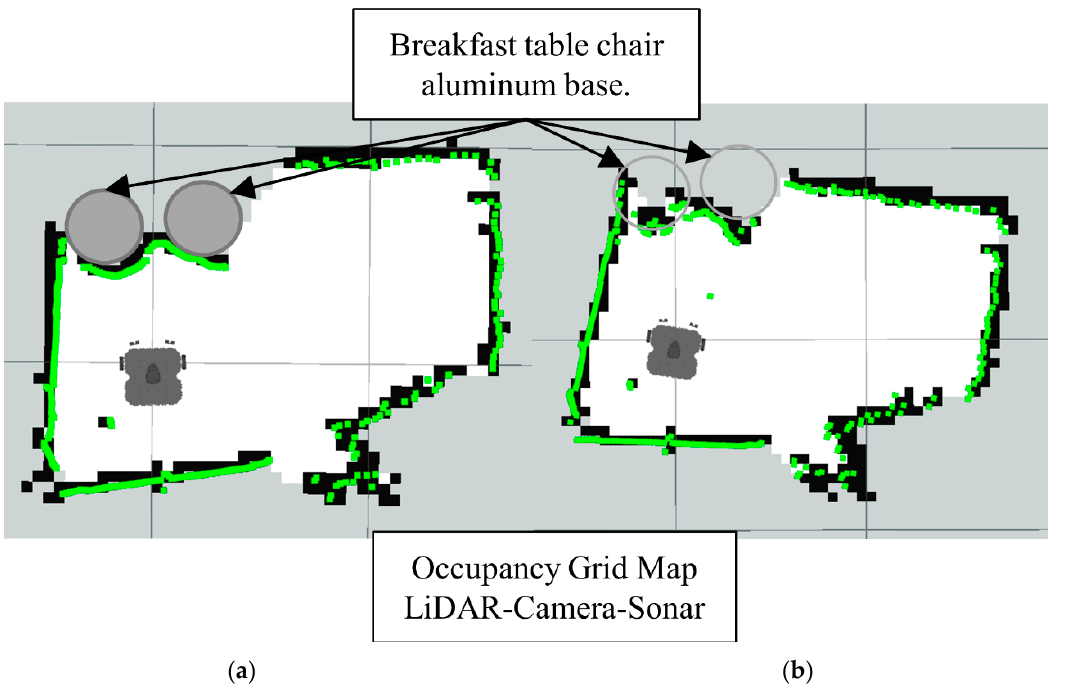
Figure 22. Occupancy grid maps showing the: ( a ) Ground truth (reference map); ( b ) LiDAR-Camara-Sonar fusion generated map.